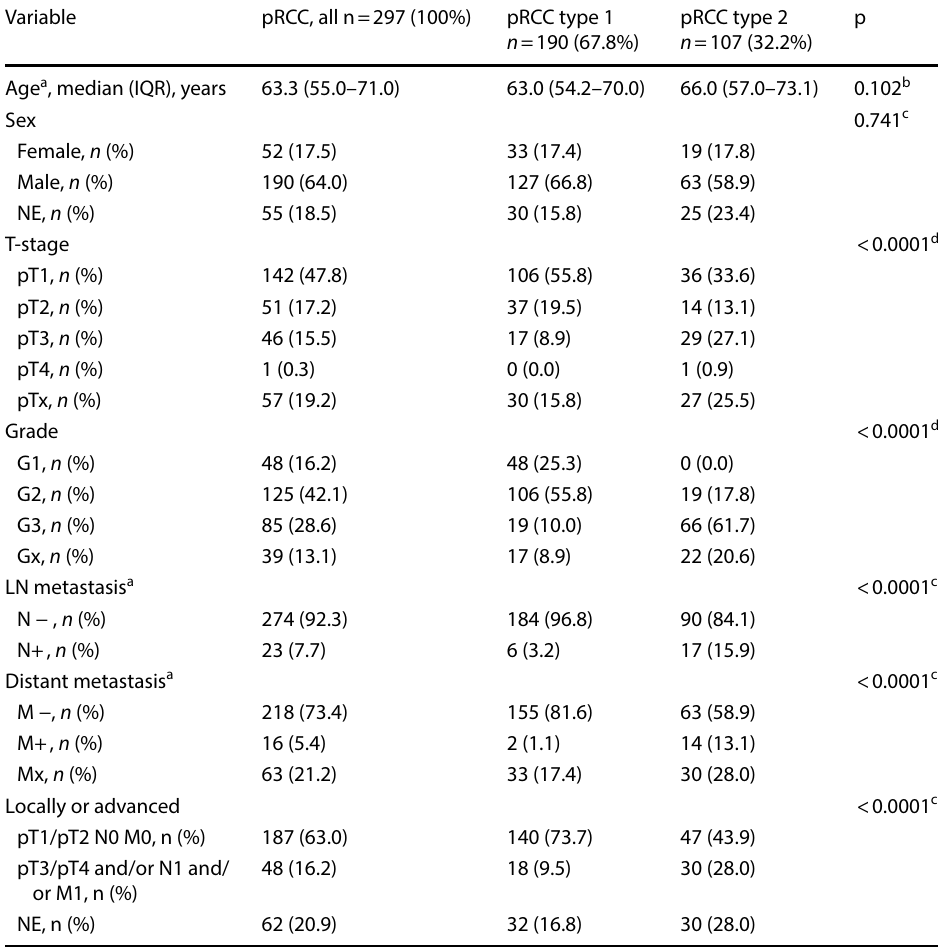
Table 1 Characteristics of patients with papillary renal cell carcinoma type 1 and type